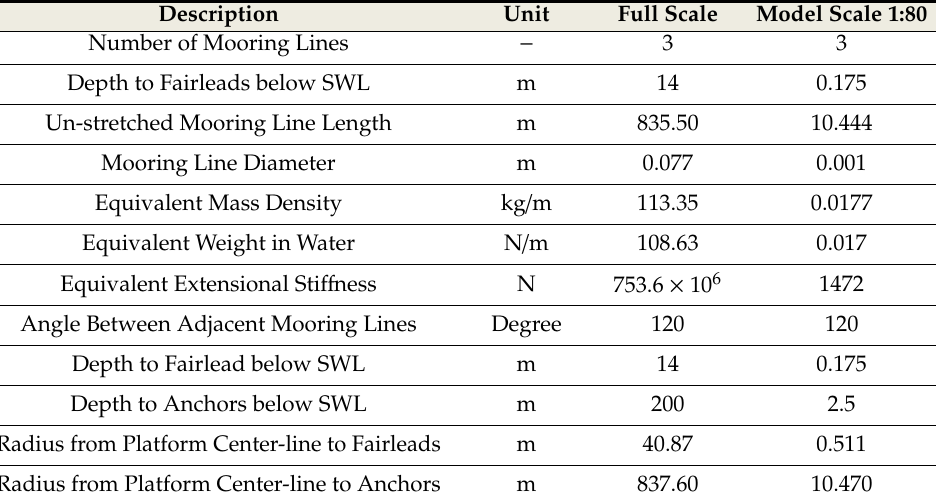
Table 3. Mooring line